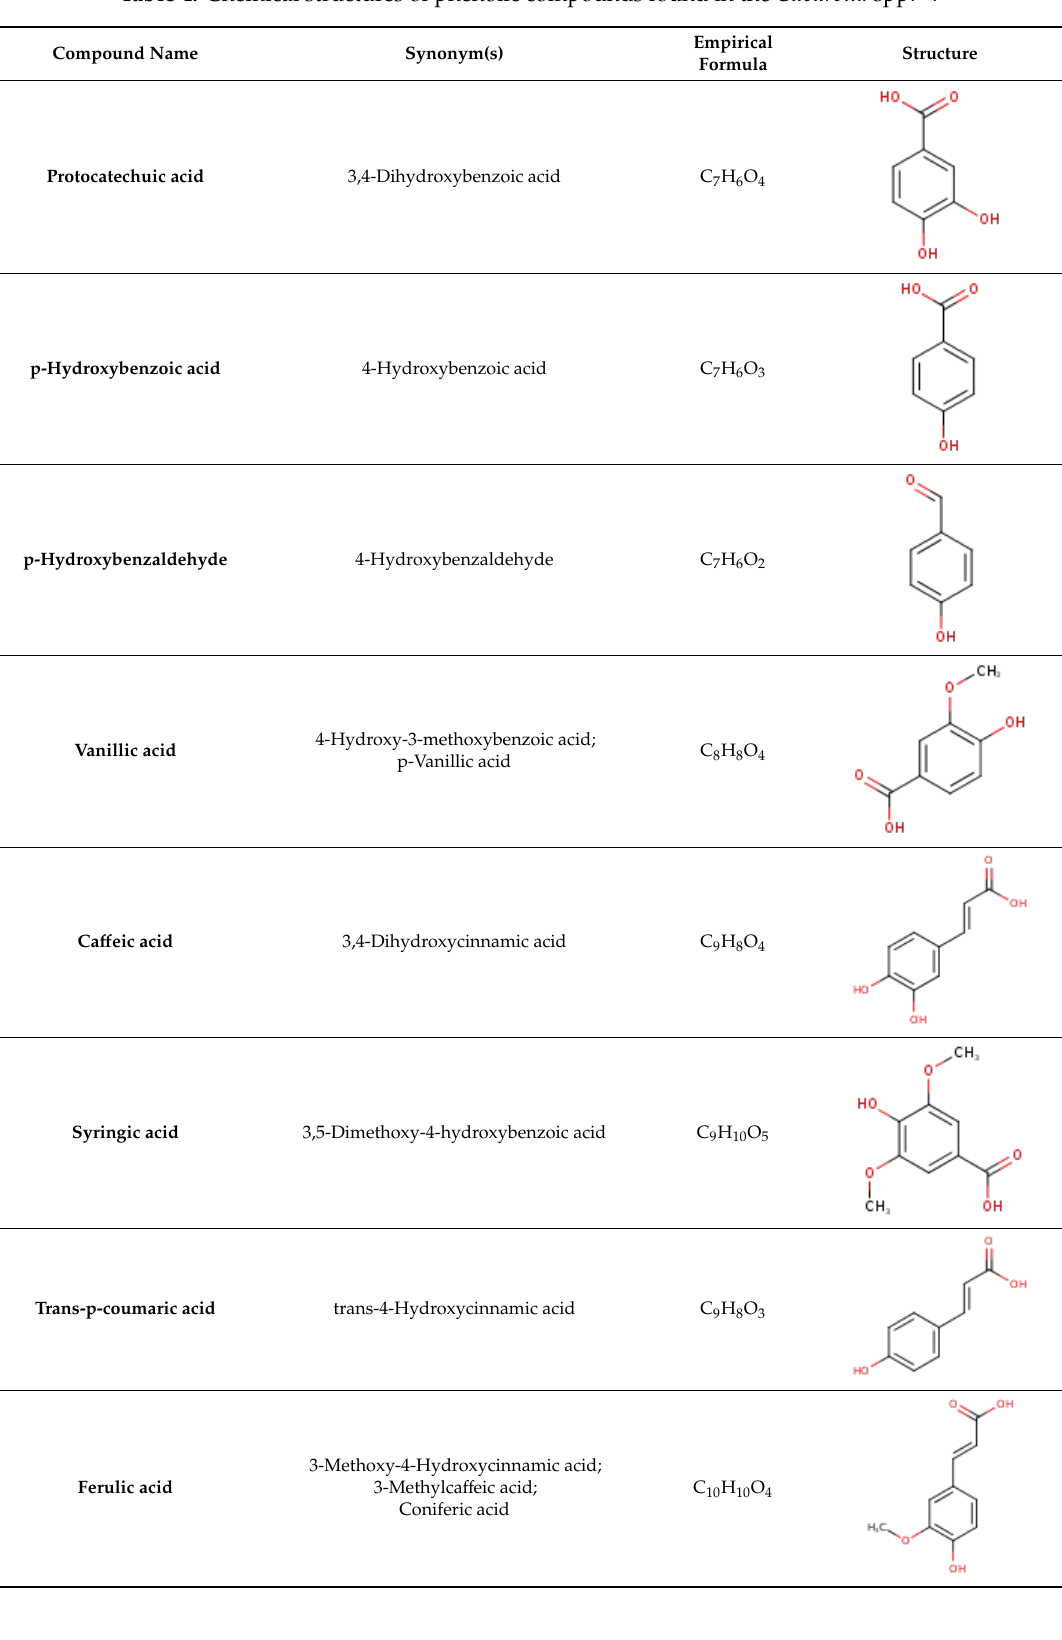
Table 4. Chemical structures of phenolic compounds found in the Cucurbita spp. *.